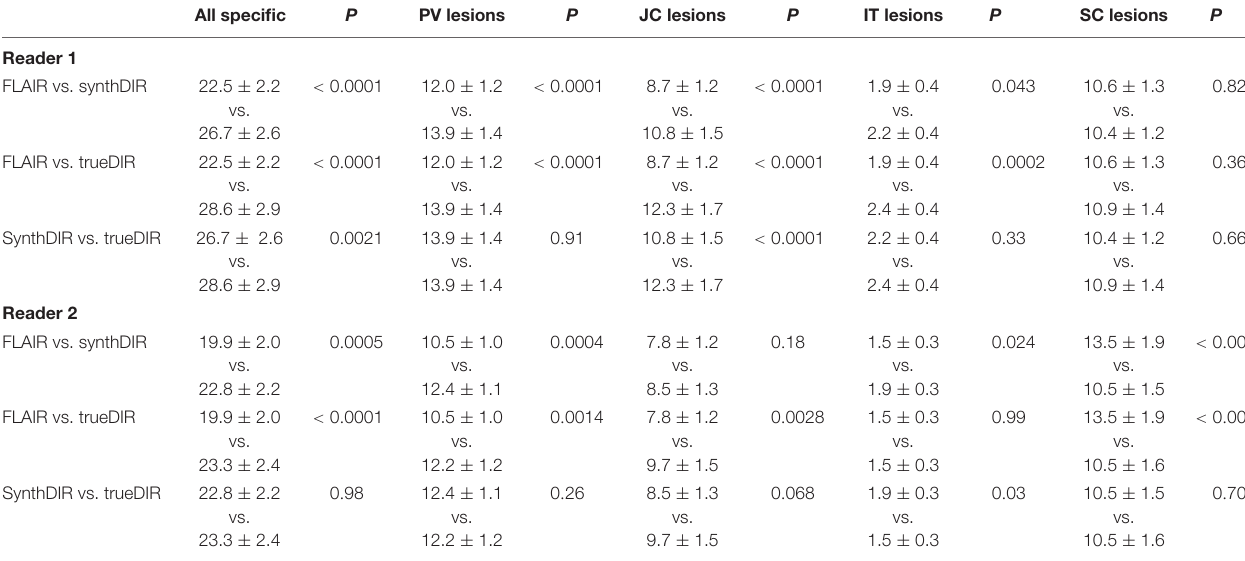
TABLE 2 | Lesion counts for all locations and both readers.